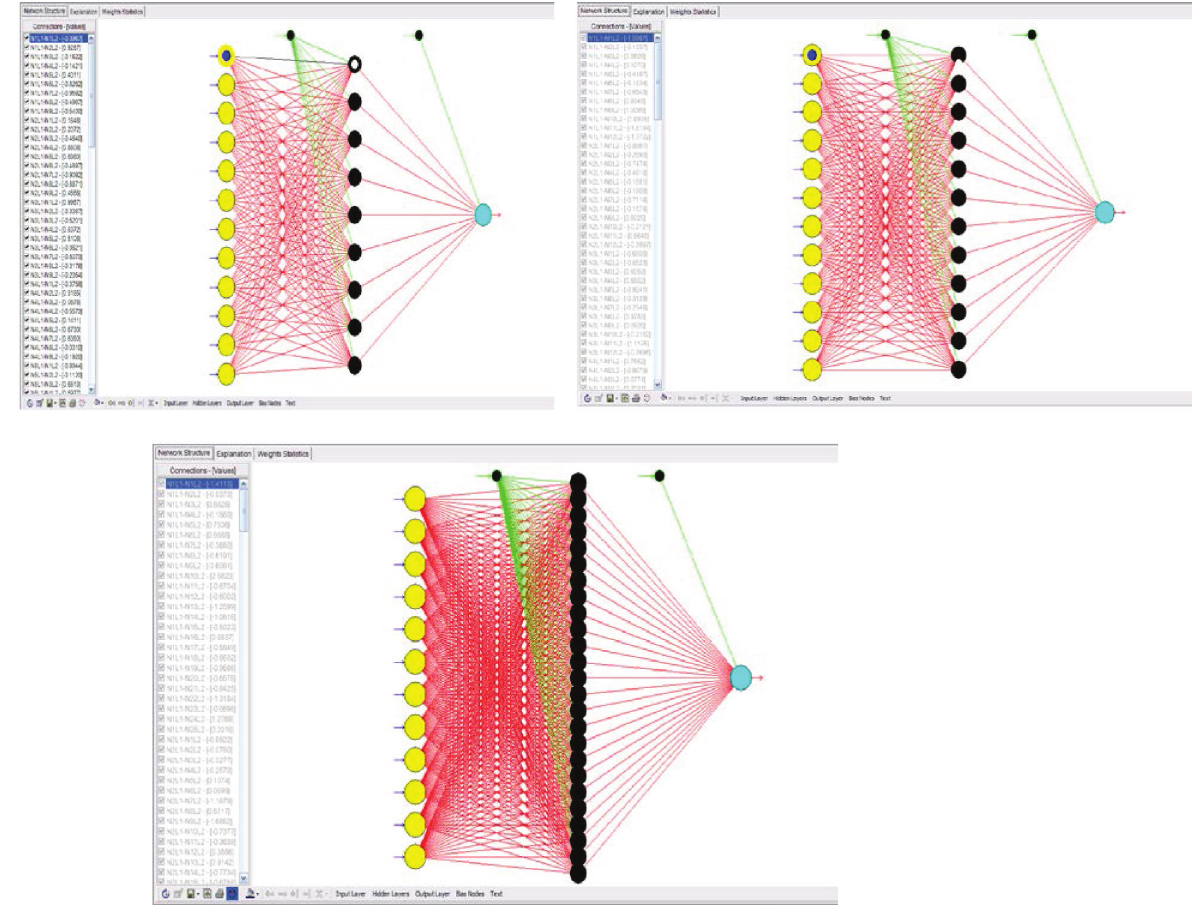
Fig. 1. Hidden layer structures of neural network